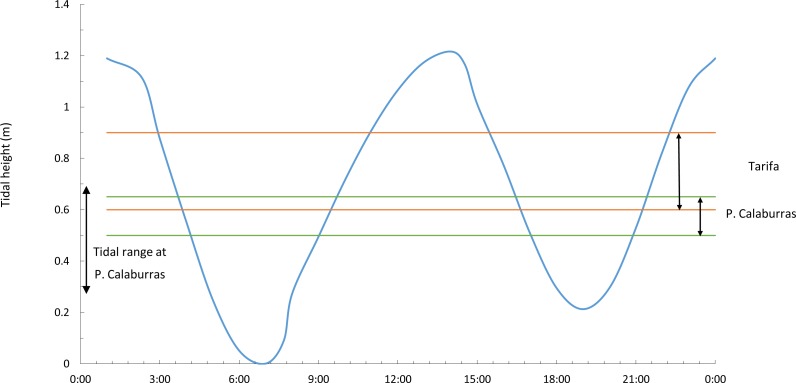
Tidal range and vertical ranges of Fucus guiryi at Tarifa and at Punta Calaburras.Daily (hours:minutes, Coordinated Universal Time) tidal height at Tarifa and maximum tidal range at Punta Calaburras on 16th July 2011, and vertical ranges of Fucus guiryi at Tarifa and Punta Calaburras. Daily tidal regime at Punta Calaburras has not been included because no data are available.